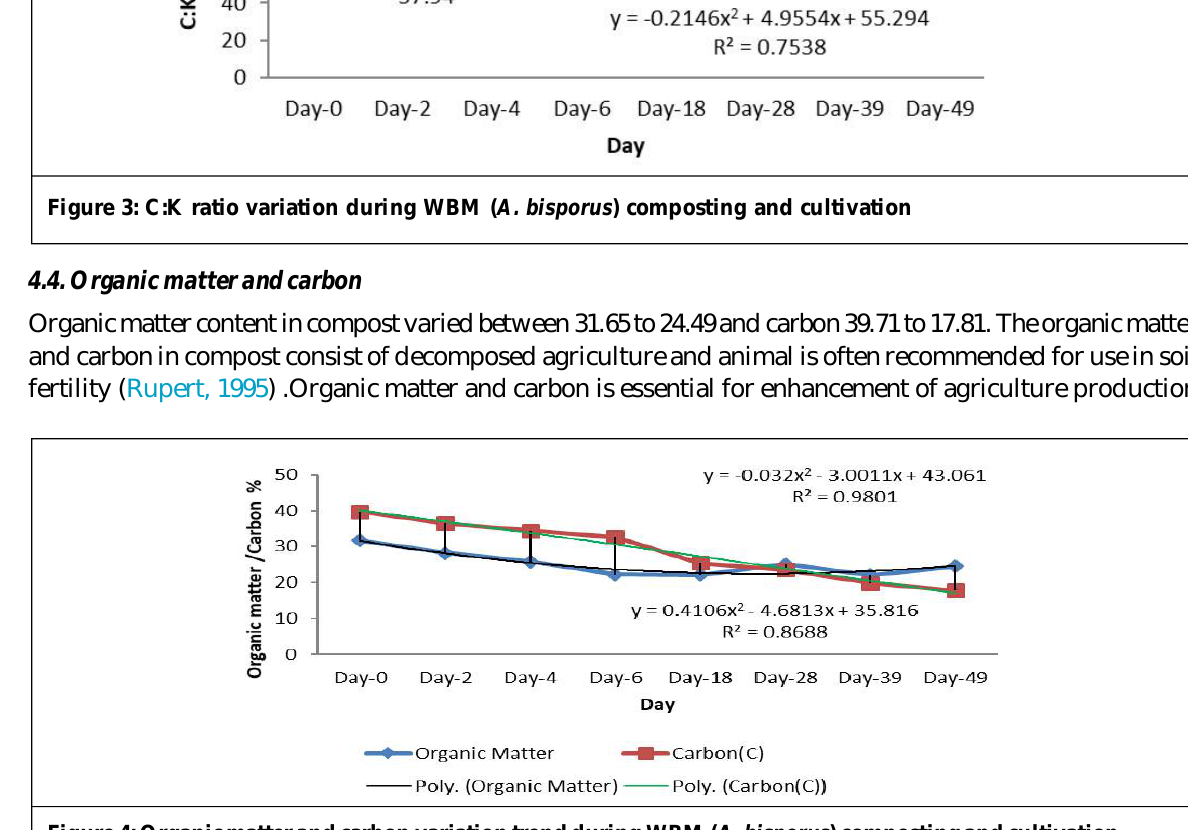
Figure 4: Organic matter and carbon variation trend during WBM ( A. bisporus ) composting and